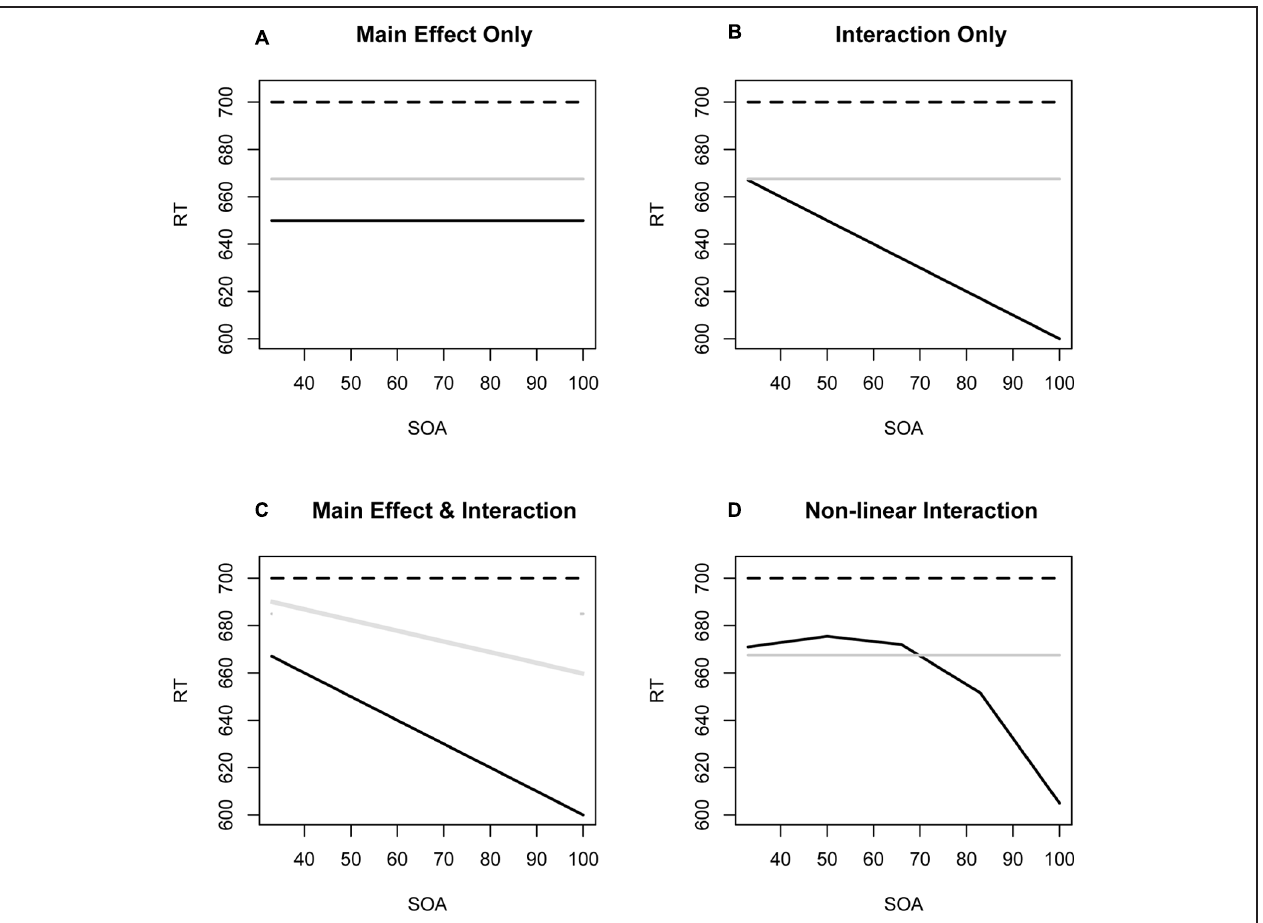
FIGURE 1 | Four theoretically plausible profiles of the evolution of facilitation at very short stimulus onset asynchronies (SOAs) for semantically similar (black solid lines) and semantically dissimilar (gray solid lines) morphologically related pairs relative to unrelated pairs (discontinuous lines). (A) Full and instantaneous